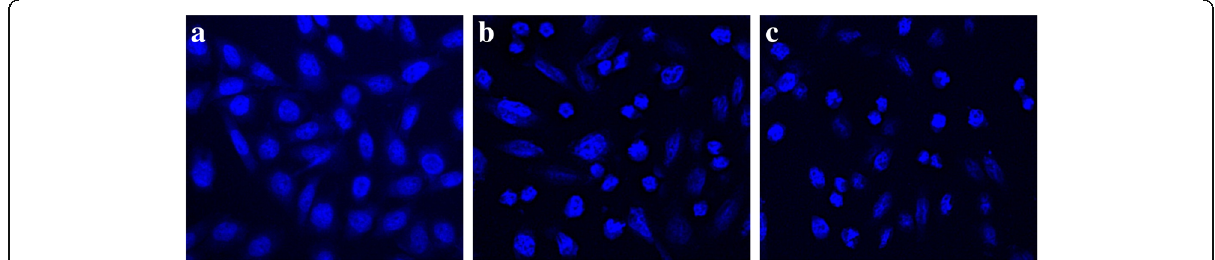
Fig. 5 Confocal microscopy ( a ) HepG2 cells with no treatment ( b ) HepG2 cells treated with 10 μ M camptothecin ( c ) HepG2 cells treated with IC 50 (75.864 μ g/ml) of the herbal